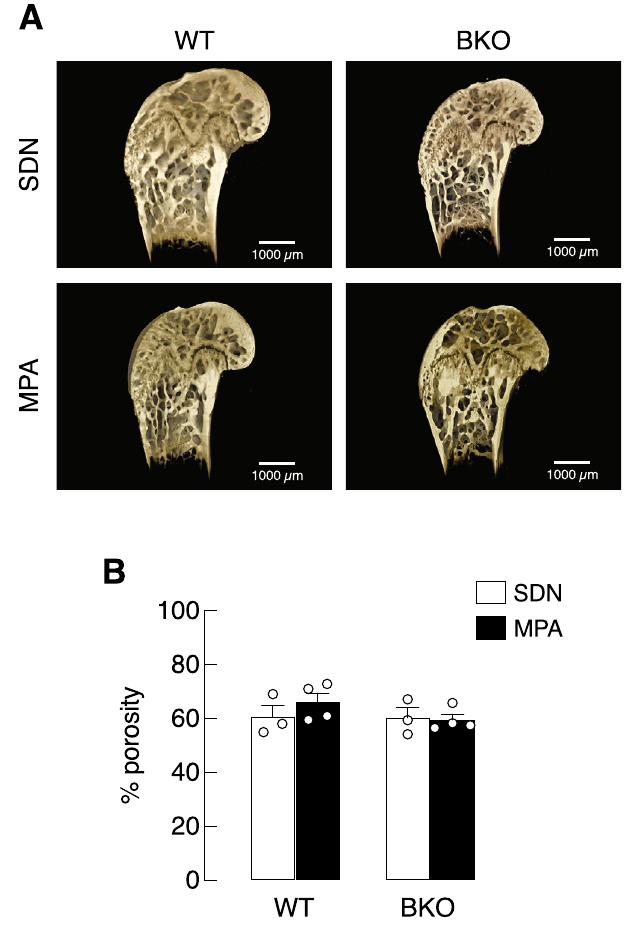
Figure 7. ( A ) A representative images of longitudinal microstructures of tibiae obtained from β-globin knockout (BKO) and wild-type (WT) mice after mild-intensity physical activity (MPA) training or sedentary (SDN) period as analyzed by SRXTM. (scale bar, 1000 µm). ( B ) Quantitative analyses of trabecular bone porosity in the proximal tibial metaphysis of BKO and WT mice subjected to MPA training or SDN control. Values are means ± SE (n =